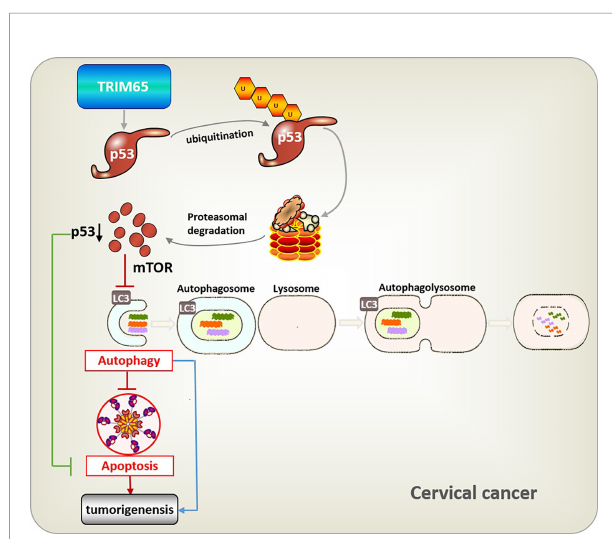
FIGURE 6 | Integrative model illustrating the role of TRIM65 in human cervical cancer. TRIM65-catalized ubiquitylation and degradation of p53, which suppresses directly apoptosis, or causes the inhibition of autophagy through classical mTOR signaling to reduce pathogen degradation, as well as attenuating autophagy-associated apoptosis, thus leading to the tumorigenesis and metastasis of cervical